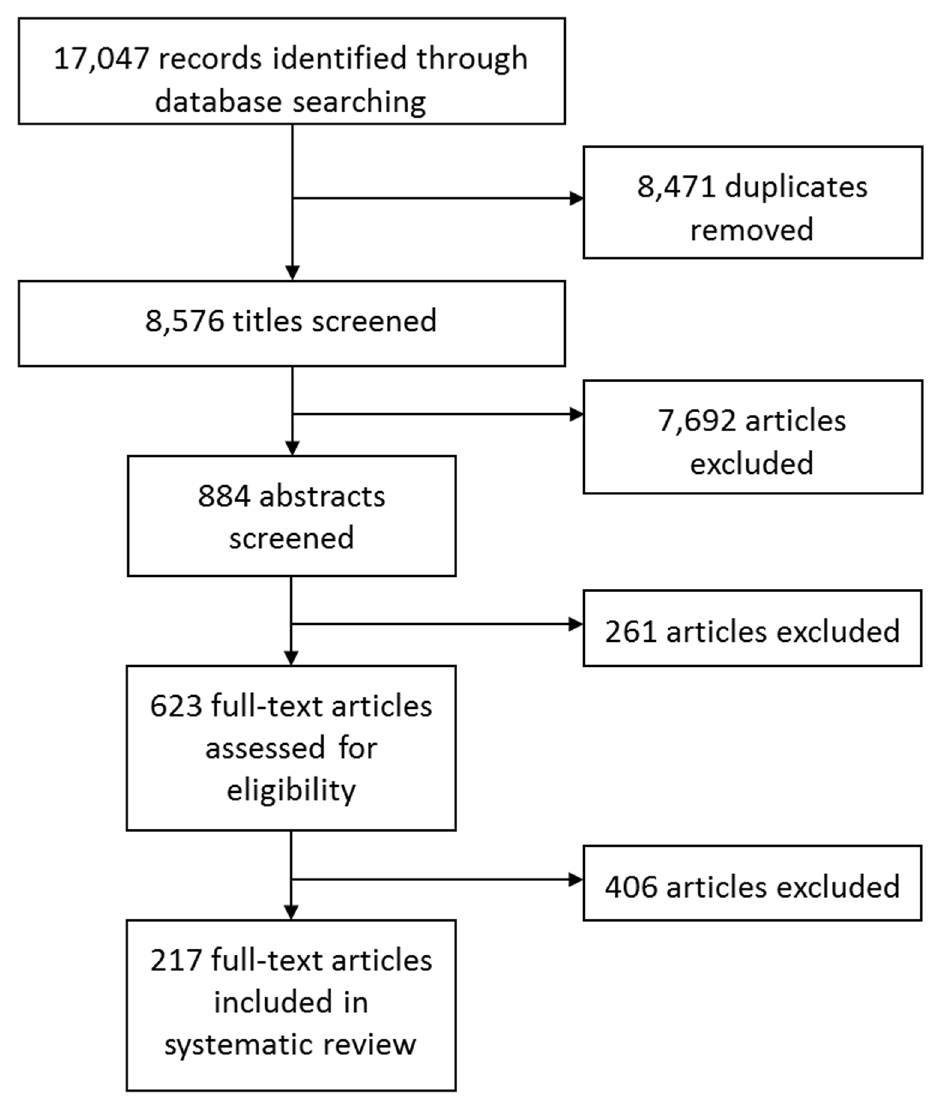
Fig 1. Flow diagram for article